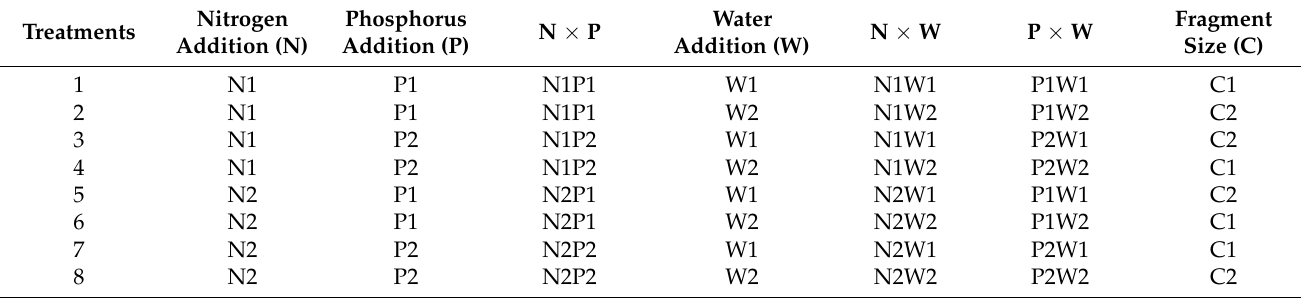
Table 2. Standard Taguchi L 8 (2 7 ) array experimental